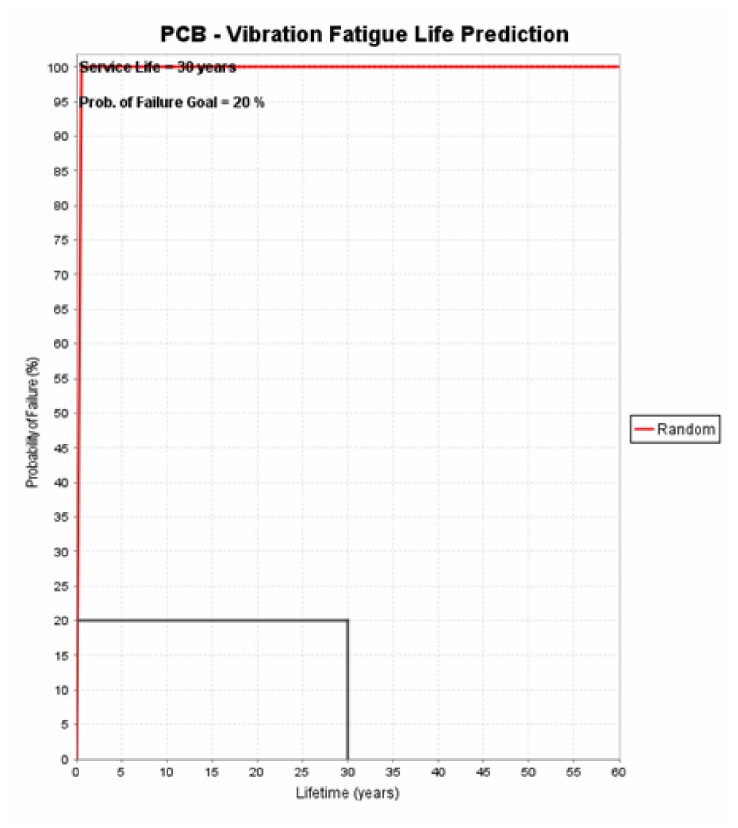
Figure 13. Life prediction of PCB under vibration fatigue.